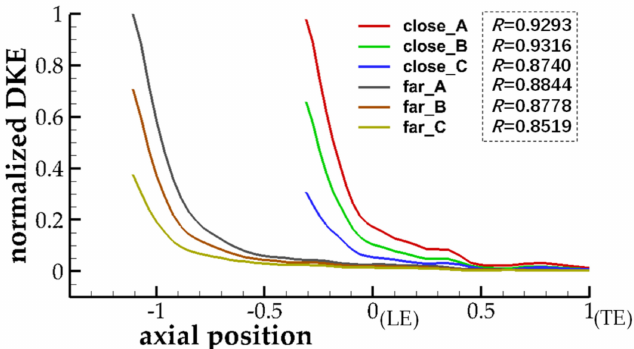
Figure 18. Comparison of the DKE decay.